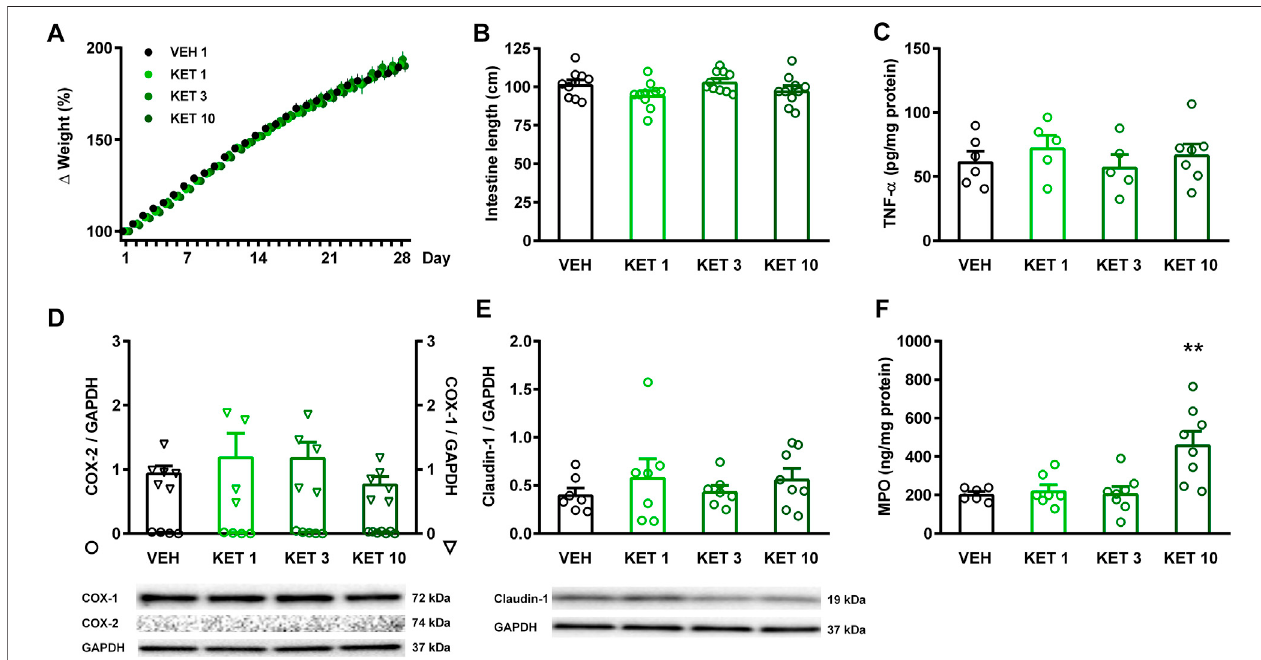
FIGURE1| Theeffectofketorolac (KET)givenat different doses(1, 3and 10 mg/kgper os, oncedailyfor four weeks) onanimalweight,small intestine length, and expressionofin fl ammatorymediatorsandclaudin-1.Panel A :resultsareexpressedasthemean+SEM.Panels B – F :Circlesrepresentthedataofeachrat,barsindicate themean+SEM.Forstatisticalanalysistwo-wayrepeatedmeasuresANOVAfollowedbyHolm-Sidakposthoctest (A) ,andone-wayANOVAwithHolm-Sidakposthoc test (B – F) were used, n (cid:2) 4 – 10/group. ** p < 0.01 compared to vehicle-treated group.